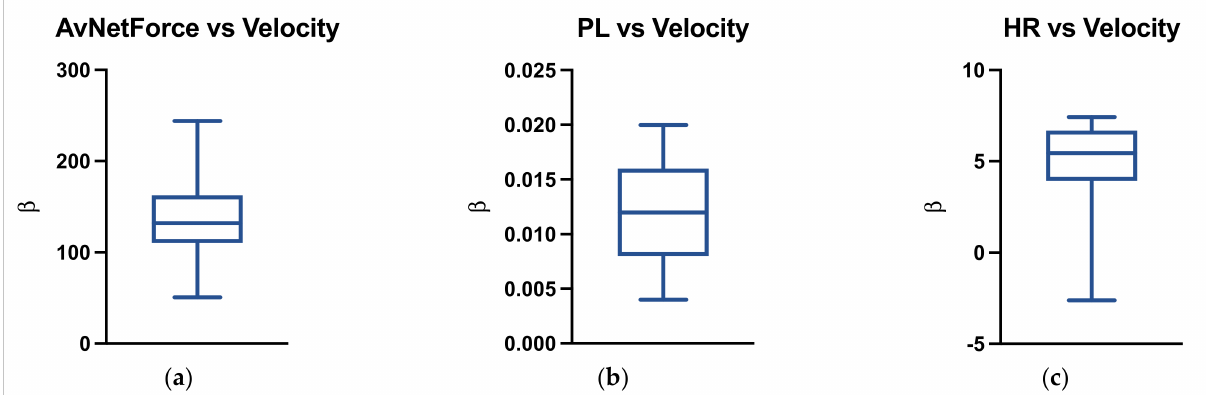
Figure 3. The figure reports the average and SD of the coefficient of the linear fitting ( β ) between velocity and the metrics considered. AvNetForce = average net force; PL = Player Load; HR = heart rate. ( a ) AvNetForce vs Velocity; ( b ) PL vs Velocity; ( c ) HR vs